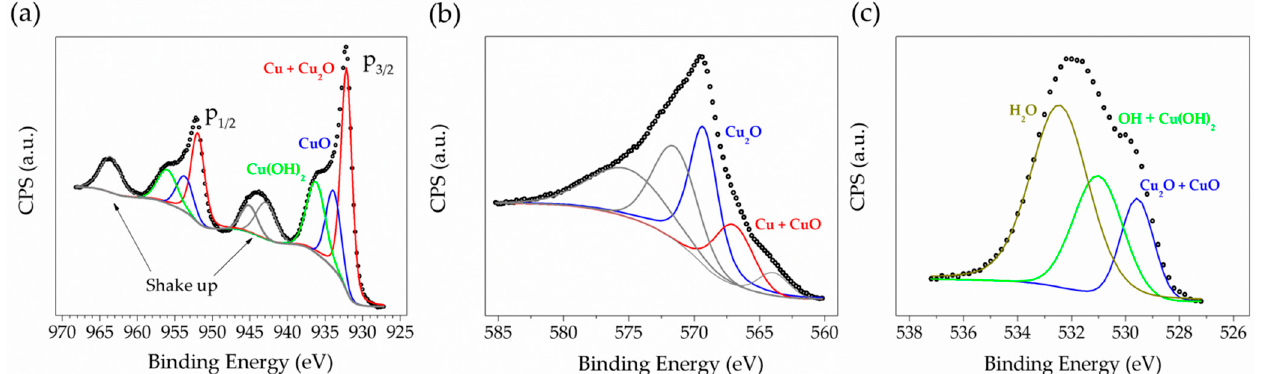
Figure 2. HRXPS spectra of ( a ) Cu-2p, ( b ) Cu-Auger and ( c ) O-1s, for Cu foils anodized at 5 °C applying constant potential of 10 V during 3 min in a 0.1 M KOH + 10% v / v H 2 O electrolyte + 0.1% w / v NH 4 F and dissolved in ethylene glycol.